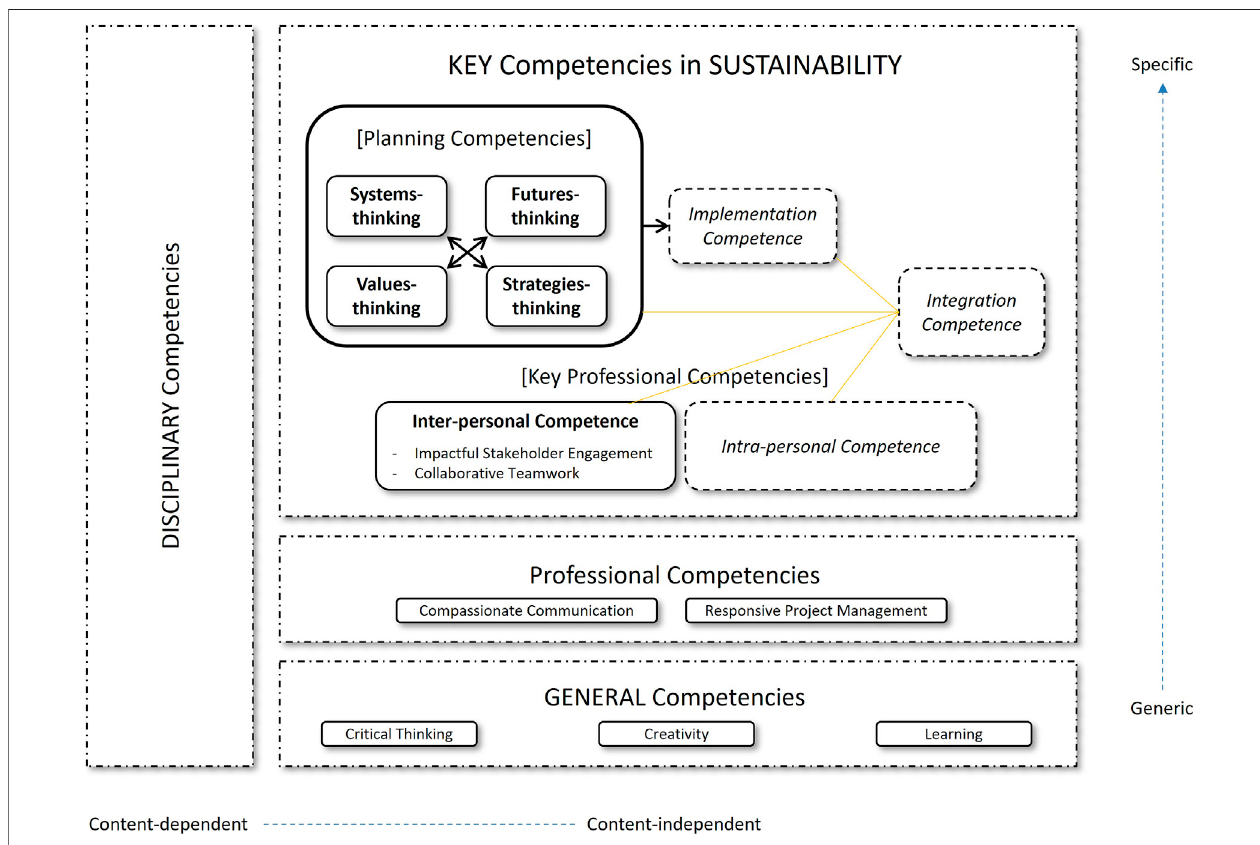
FIGURE 6 | Uni fi ed framework of competencies for advancing sustainability transformations; centered on 8 key competencies in sustainability with 5 established (bold) and 3 emerging (italic); and complemented by disciplinary, general, and other professional competencies.